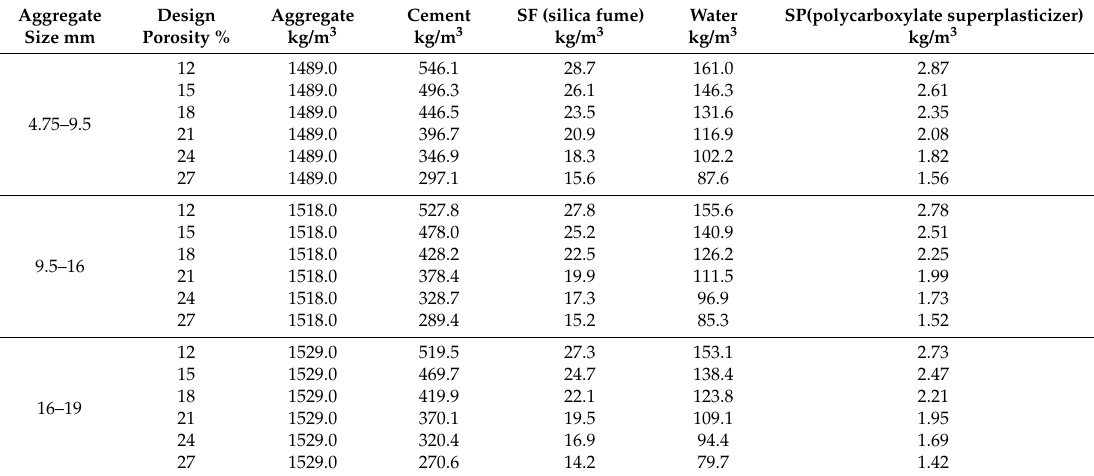
Table 4. Mix proportions of pervious concrete.